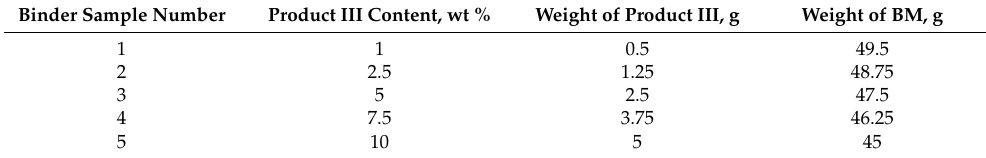
Table 1. Ratio of components in the mixture used for obtaining the modified